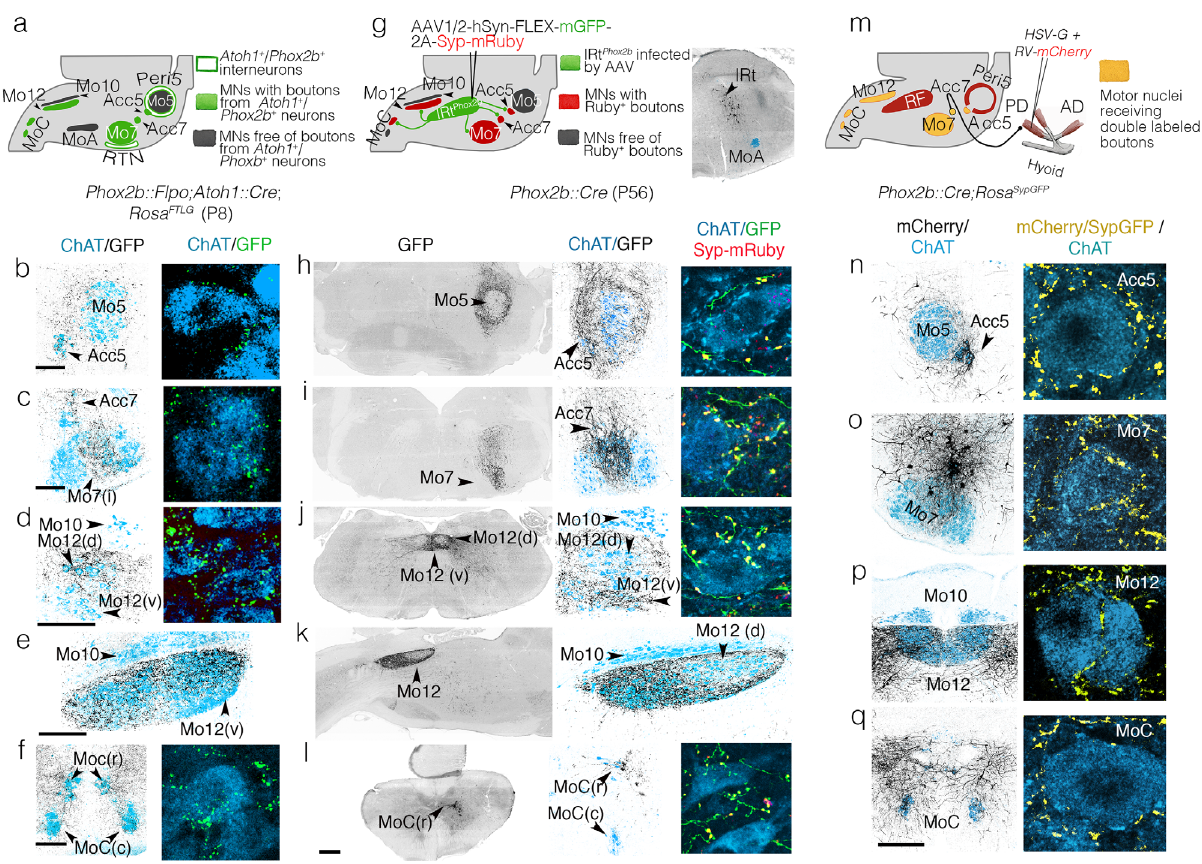
Fig. 3 Projections of IRt Phox2b and Peri5 Atoh1 on hindbrain motoneurons. a Strategy for the transgenic labeling of projections from Peri5 Atoh1 (and RTN) and summary of the results; b – f Coronal ( b – d , f ) or parasagittal ( e ) sections through a P8 hindbrain showing GFP -labeled boutons (black) on motoneurons (blue) at medium (left) and high (right) magni fi cation. g Strategy for the viral tracing of projections from IRt Phox2b and summary of the results (left), and mGFP-labeled infected cells of IRt Phox2b (right); h – l Coronal ( h – j , l ) or parasagittal ( k ) sections through a P56 hindbrain showing the GFP -labeled fi bers (black) of IRt Phox2b neurons at low (left) and medium (middle) magni fi cations, and in extreme close-ups (right), together with Syp-mRuby labeled boutons (yellow) on motoneurons (blue). m schematic for retrograde tracing of premotor neurons for the right posterior digastric muscle, in